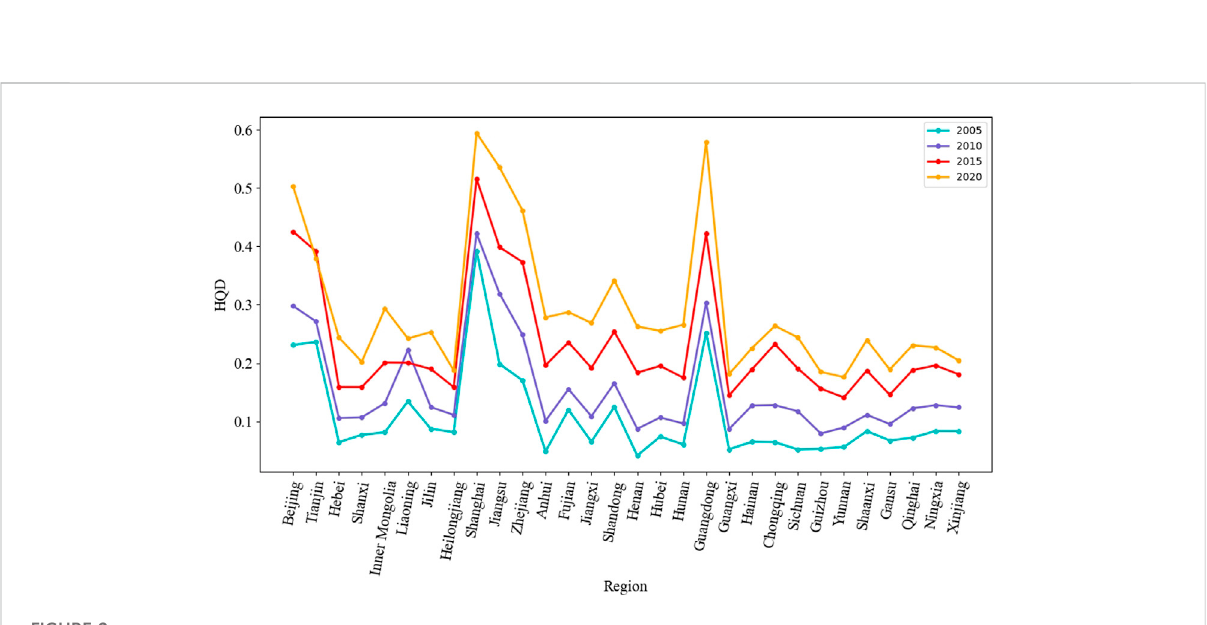
FIGURE 2 HQD temporal line chart of 30